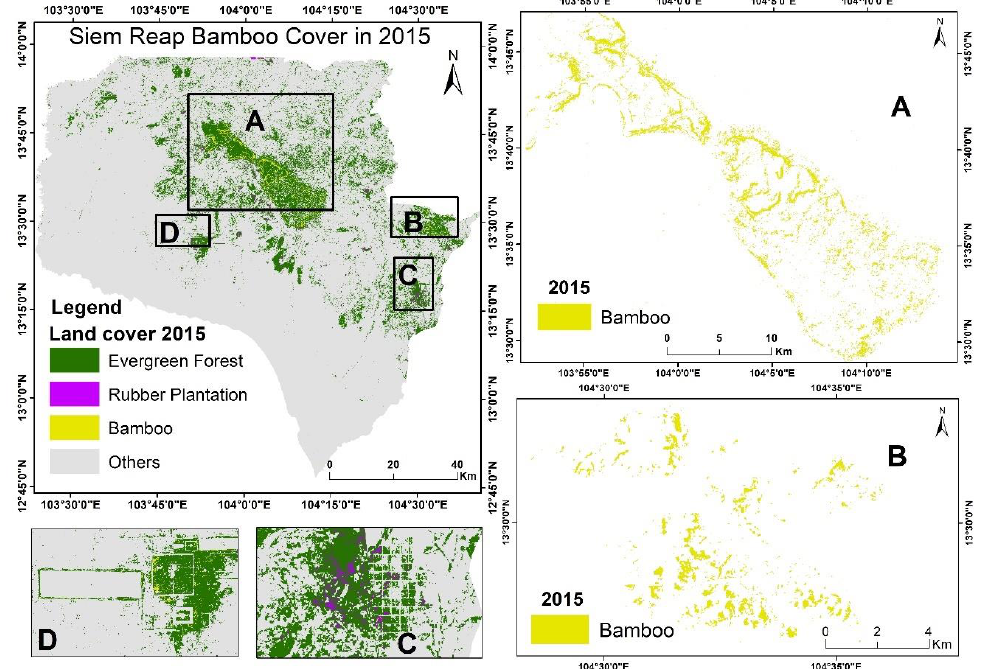
Figure 11. Maps showing the bamboo distribution in Siem Reap in 2015. Inset maps show the locations of the natural bamboo distributions around the Kulen Mountain ( A ) and Boeng Peae Wildlife Sanctuary ( B ) and of dense evergreen forests in southeastern region of the Boeng Peae Wildlife Sanctuary ( C ) and Angkor Wat temple ( D ).